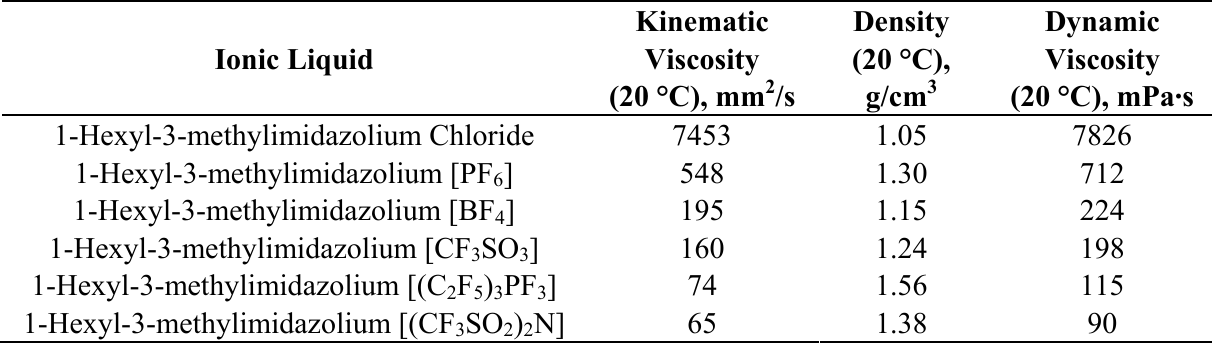
Table 4. Viscosity and density of 1-hexyl-3-methylimidazolium triflate in comparison to ionic liquids with other